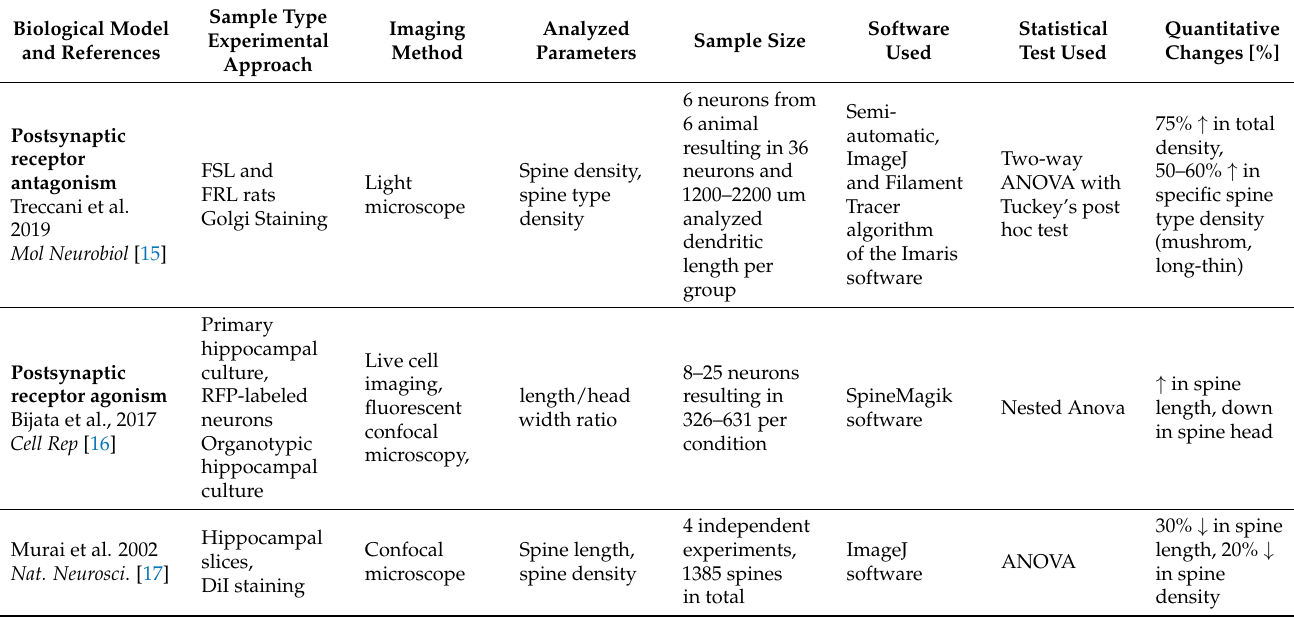
Figure 1. Typical experimental workflow. Green color indicates the dendrite, red color indicates the dendritic spines. Table 1. The experiments assessing the morphology and remodeling of dendritic spines in physiology and under stimulation. The arrows indicate an increase ( ↑ ) or a decrease ( ↓ ) of measured